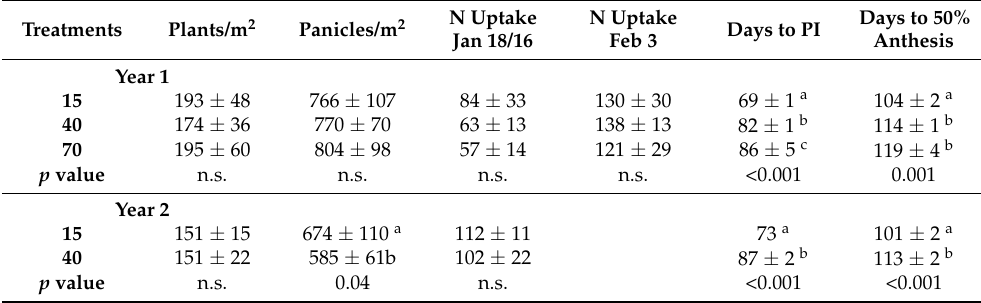
Figure 5. Long-term mean (21 years) maximum and minimum temperatures (dashed red/blue line, respectively) and maximum and minimum temperatures recorded [43] (solid red/blue line, respectively) in Year 1 ( A ) and Year 2 ( B ) with dotted dark blue line at 17 °C to show the critical minimum temperature for rice during early pollen microspore and anthesis. Square dots represent date of panicle initiation with triangles representing anthesis ( blue : 15 kPa, green : 40 kPa, brown : 70 kPa treatments). Table 4. Rice establishment, nitrogen uptake and crop development results for Year 1 and Year 2. Values ± standard deviation with different letters between rows indicating statistical significance at